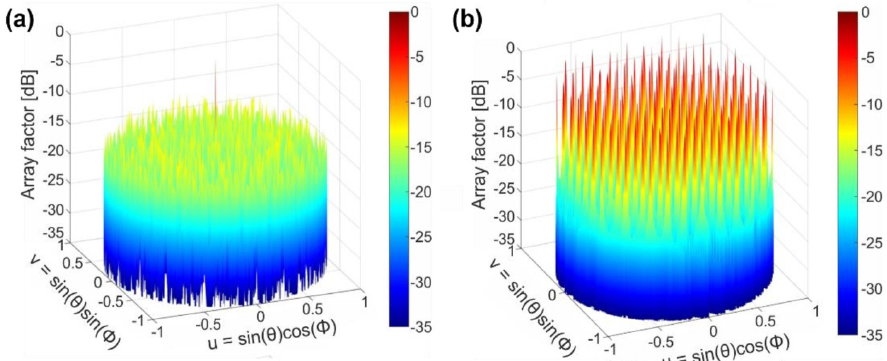
Figure 4. The array factor representation in a uv space. ( a ) Circular array: N = 10, M = 11, R 0 = 20 μm, and dr = 9 μm at θ = 0°, Φ = 0°. ( b ) Rectangular array: N = 10, M = 11, d x = d y = 9 μm at θ A = 0°, Φ A = 0°.